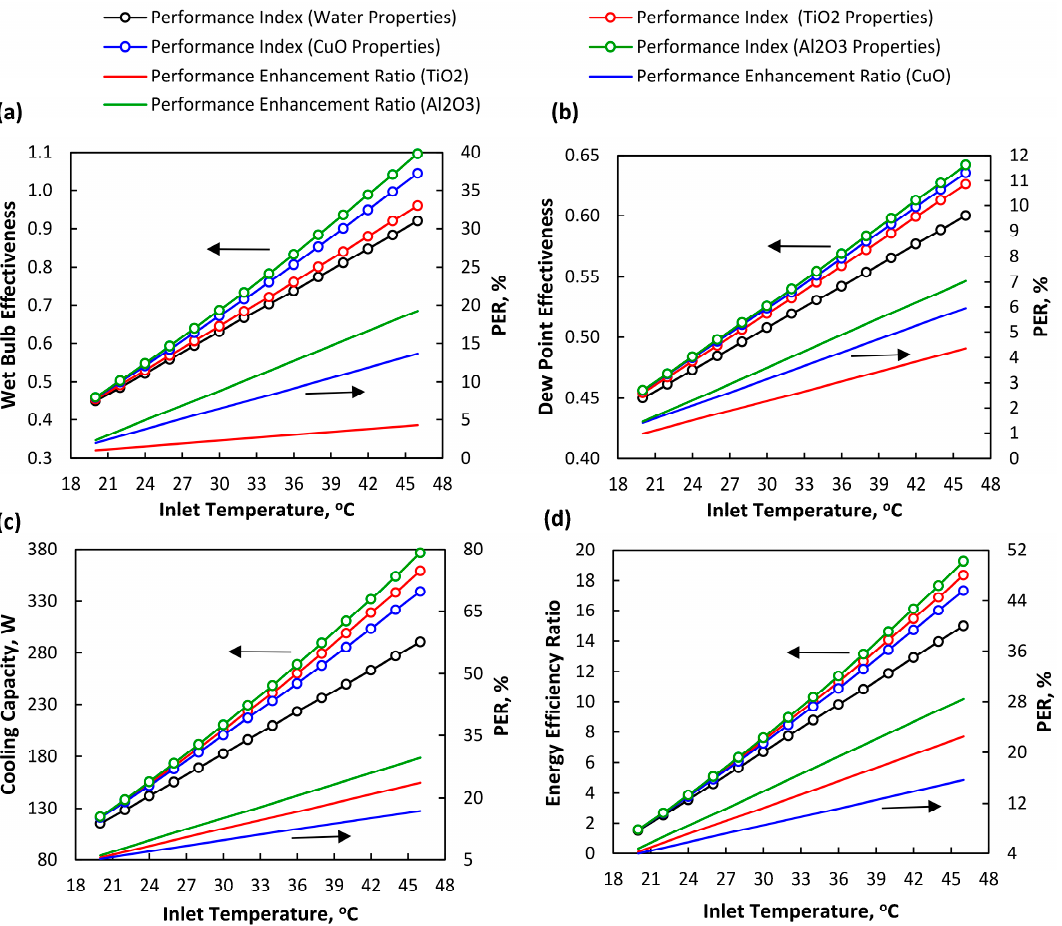
Figure 8. Influence of inlet temperature on ( a ) wet bulb effectiveness; ( b ) dew point effectiveness; ( c ) cooling capacity; and ( d ) energy efficiency ratio, with and without using nanofluids.